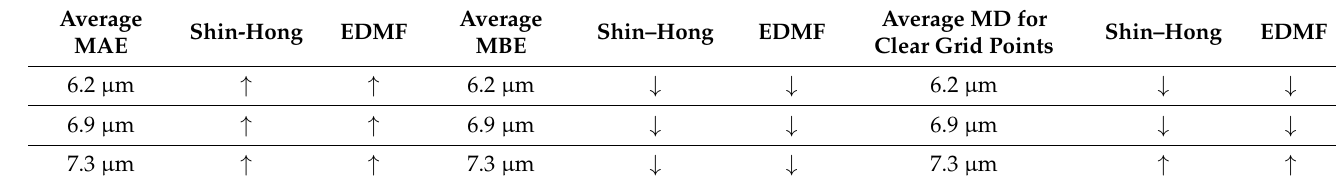
Table 4. As in Table 3 but for a comparison between the MYNN PBL scheme and the Shin–Hong and EDMF PBL schemes.